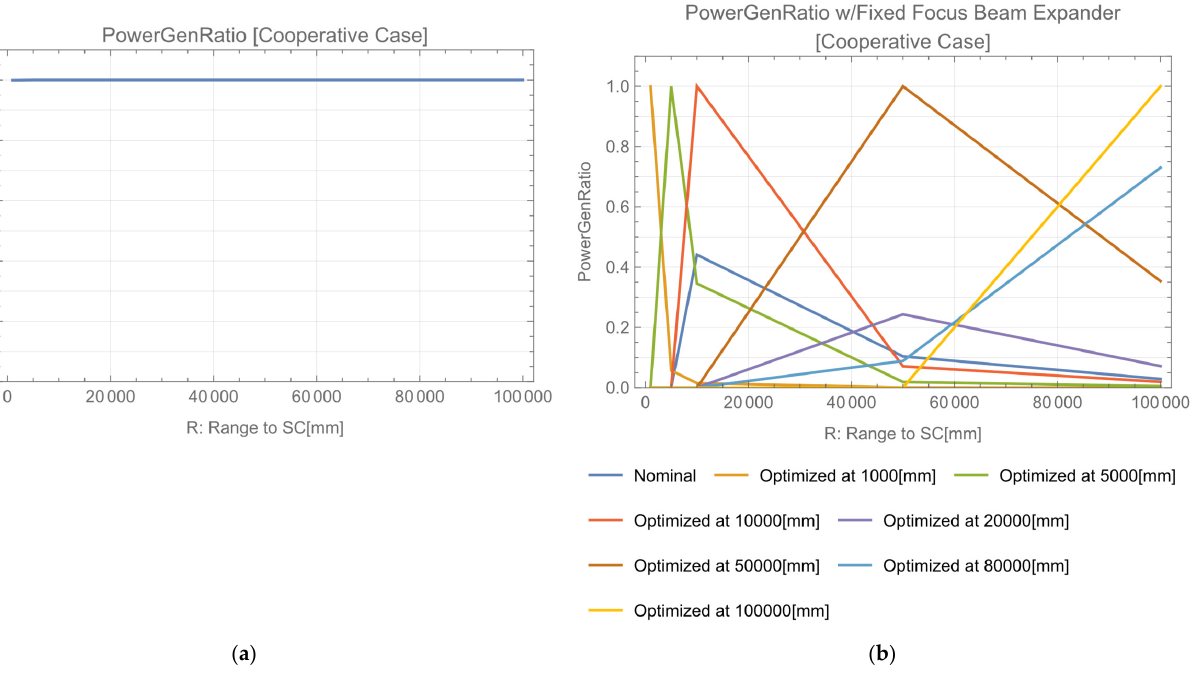
Figure 12. Range dependence of power generation ratio (Cooperative OWPT). ( a ) When the focus is adjusted for each R, the power generation ratio is stably maintained at 100%; ( b ) There is a large variation in the power generation ratio for the range from 0 m to 100 m in case where the focus is optimized and fixed at specific